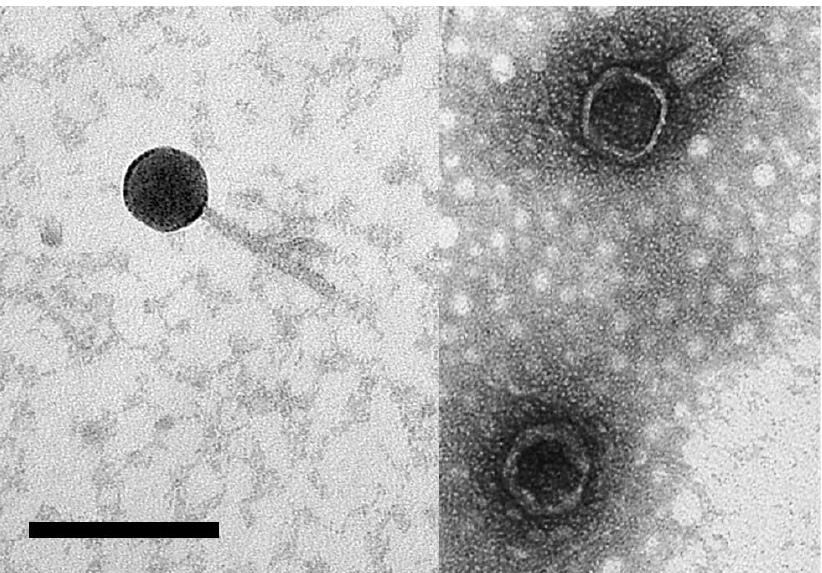
Figure 1. Electron-micrograph of halovirus Serpecor1. Negatively stained with 2% uranyl acetate. Size bar, 100 nm